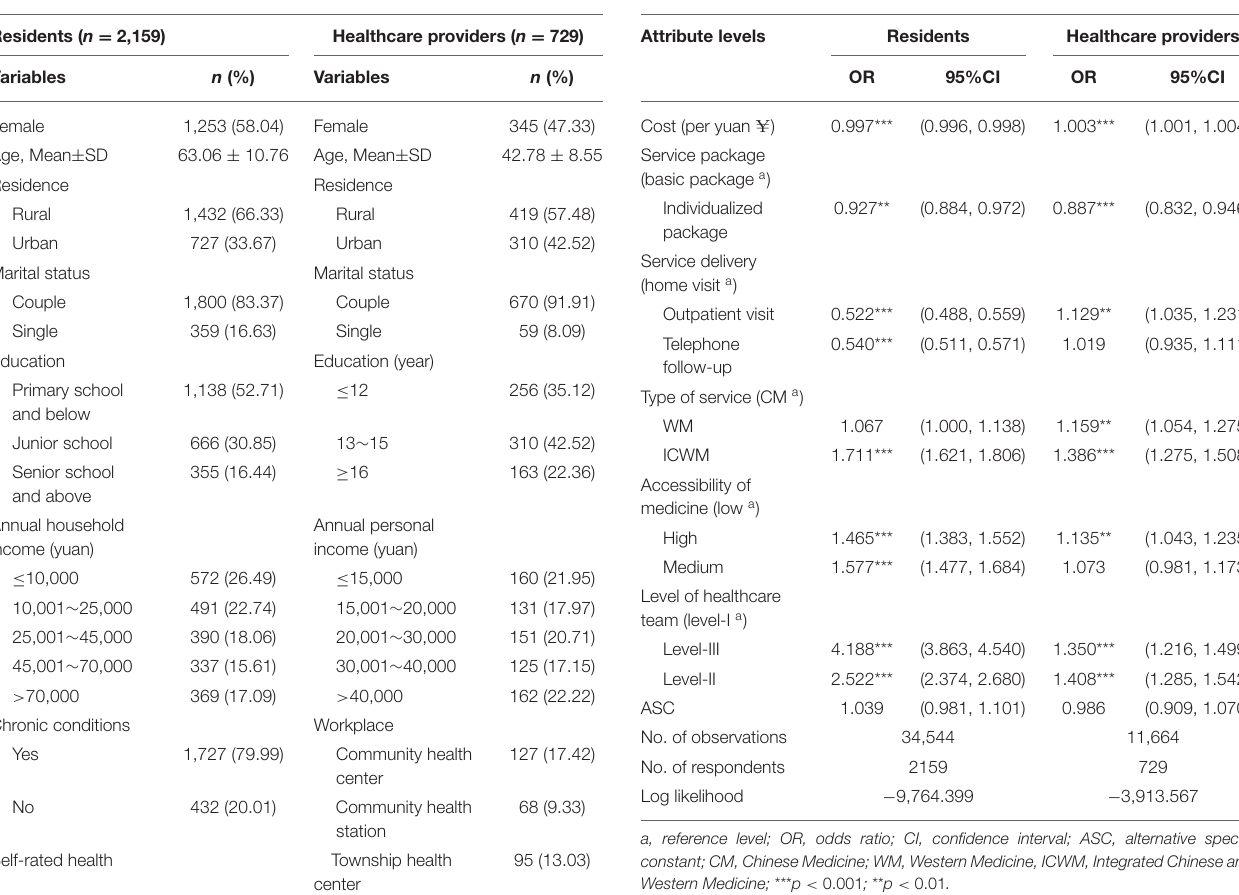
TABLE 3 | Characteristics of participants. TABLE 4 | Results of mixed logit model of residents and healthcare